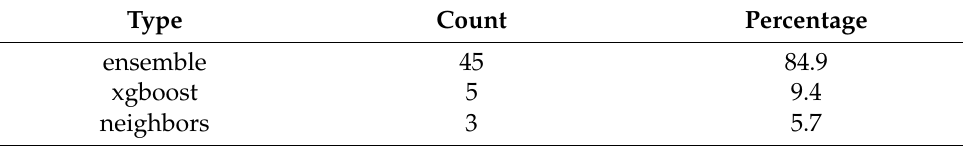
Figure 12. Average accuracy for time series grouped by estimator type. Table 5 indicates that, for the 53 elements of the time-series, the type of estimator used the most times was the ensemble : Table 5. Use of estimators in classification grouped by